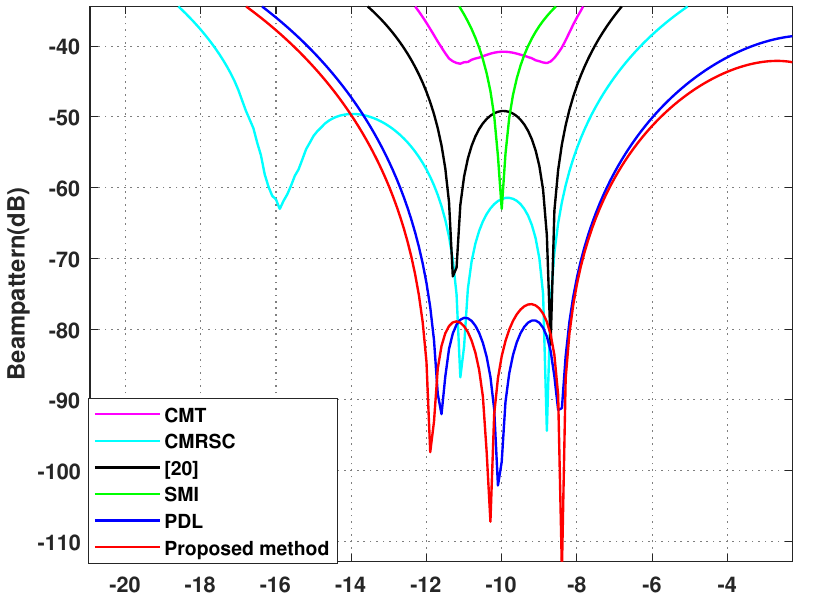
Figure 10. Local enlargement of − 10 ◦ . Simulation 4.